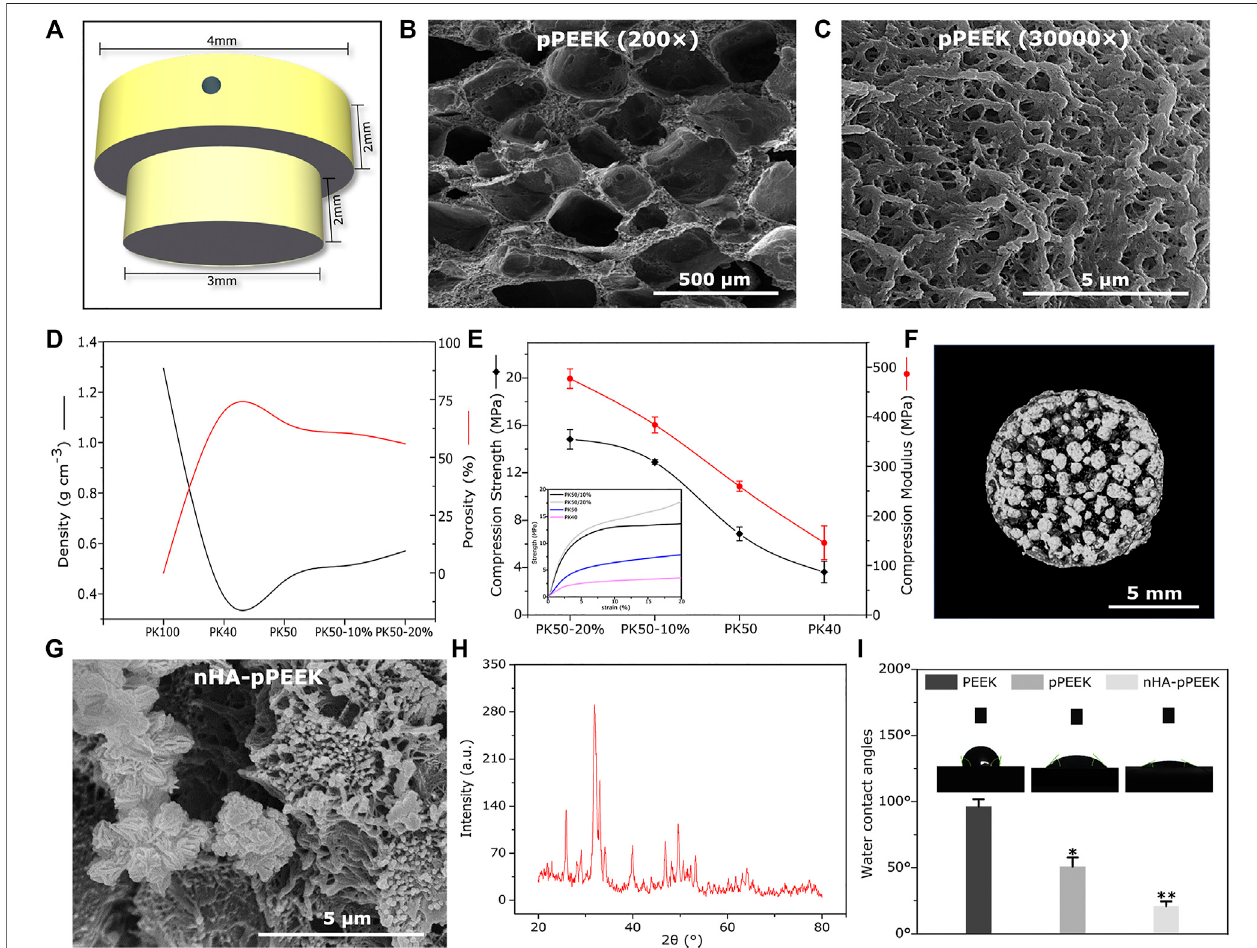
FIGURE1 | Characterization. (A) 3Dschematic ofthe implant material (B,C) SEM images ofporous materials withdifferentmagni fi cation. (D) Density and porosity ofallgroupswithdifferentsolidcontentandcompressivedegrees. (E) Mechanicalstrengthofallgroupswithdifferentsolidcontentandcompressivedegrees. (F) Micro- CT image of the material in the PK50-20% group. (G) SEM picture of synthetic nHA. (H) XRD diffractogram for samples of synthetic nHA. (I) The water contact angle analysis of the different